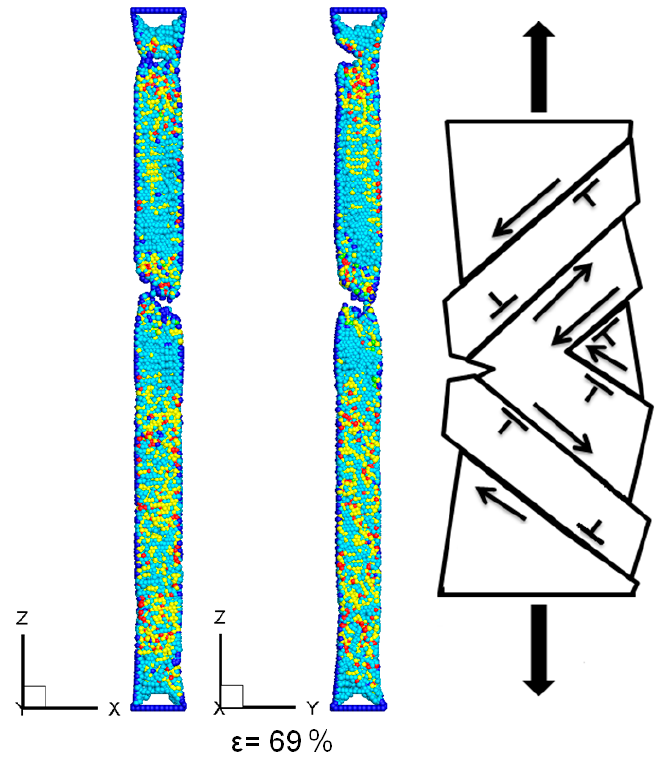
Figure 9. Fracture pattern of (001)-oriented SiNW by tensile stress. (blue: incomplete nanostructure with CN < 4; cyan: CN = 5 meta-stable phase with CN = 5; yellow: Si-II phase with CN = 6; red: high pressure phase with CN > 6).